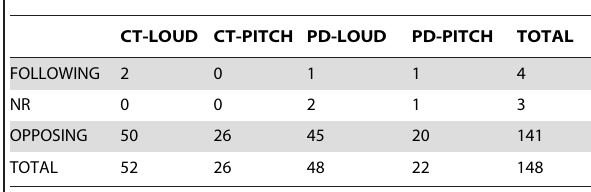
Table 2. Numbers of responses (Following, Non-Responses, Opposing) to the loudness- and pitch-shift stimuli for each group of participants (CT – Control; PD –